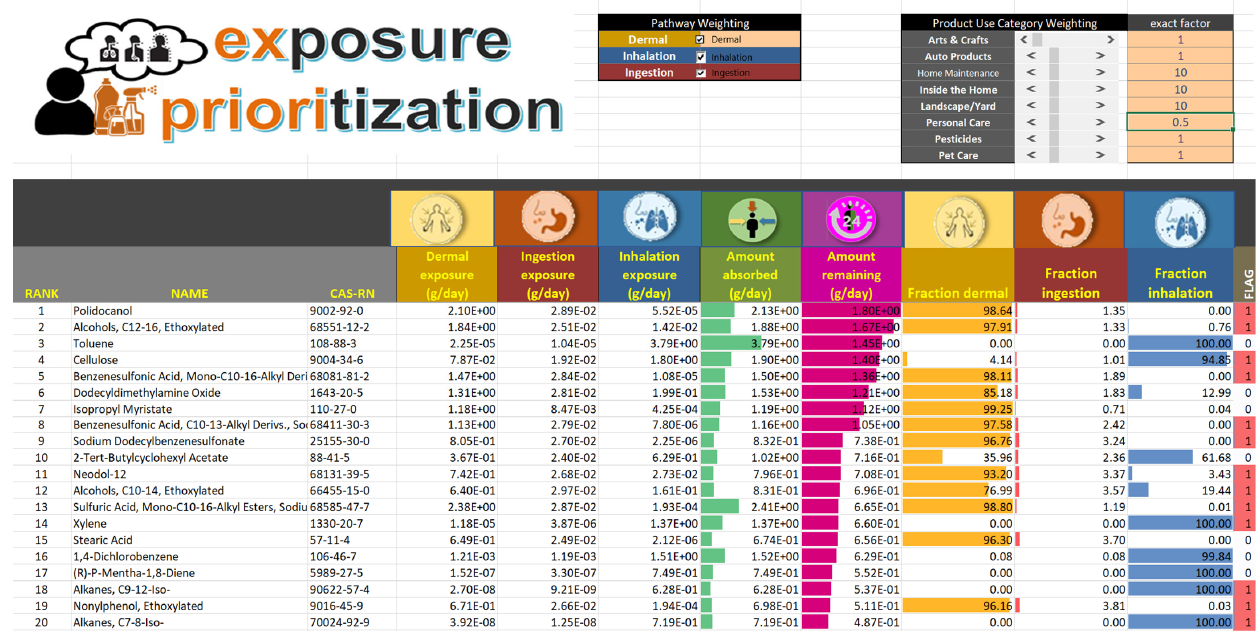
Figure 2. Screenshot of a portion of the “Dashboard” tab of the Ex Priori model spreadsheet, showing an illustrative example of chemical rankings and other model outputs.